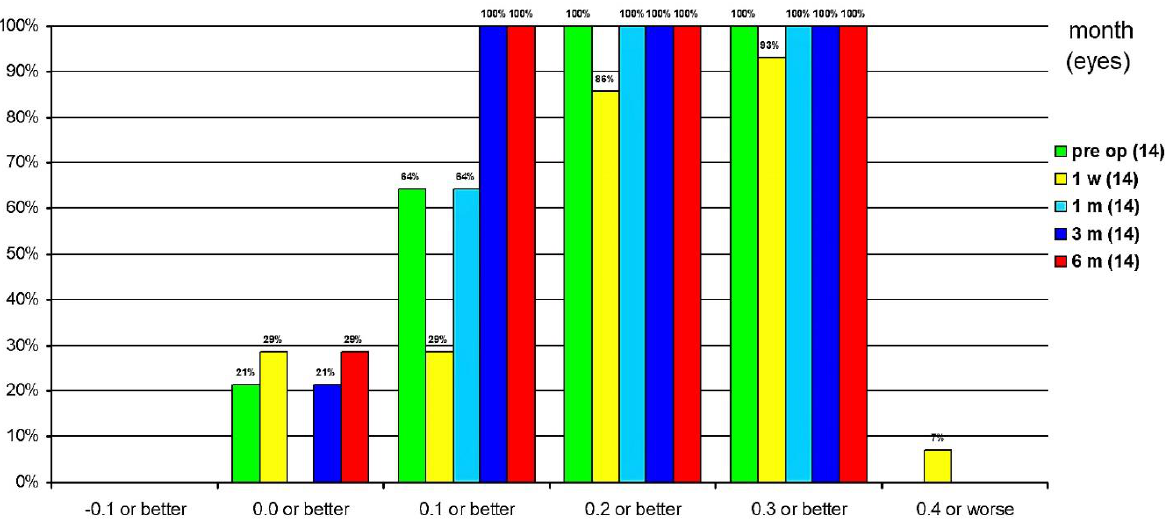
Figure 11. Cumulative corrected distance visual acuity in percentage.